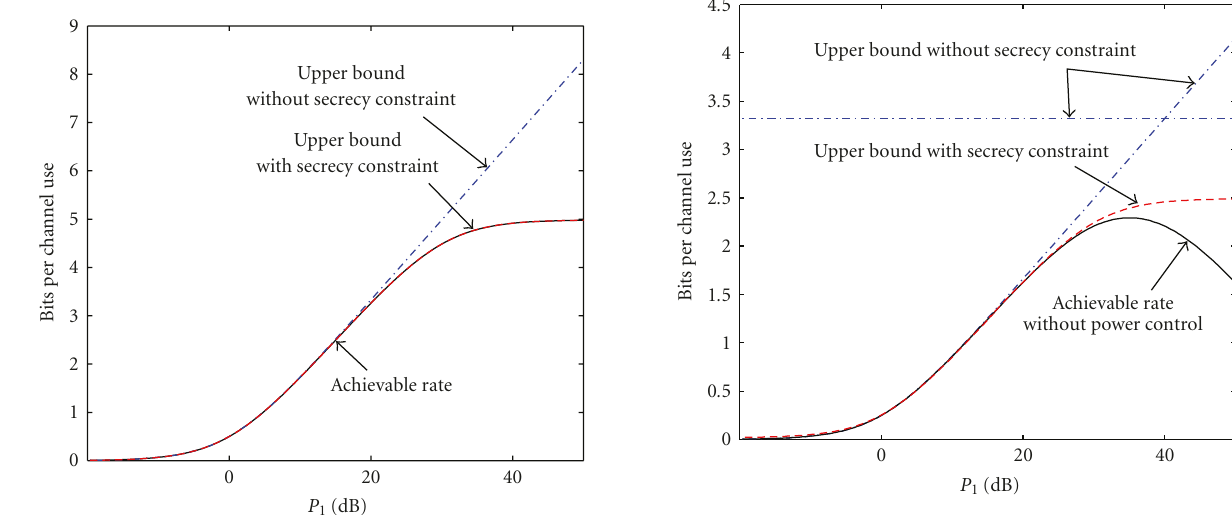
Figure 9: Secrecy Rate, P r = 30 dB, P 2 = 40 dB, α = 0 . 5